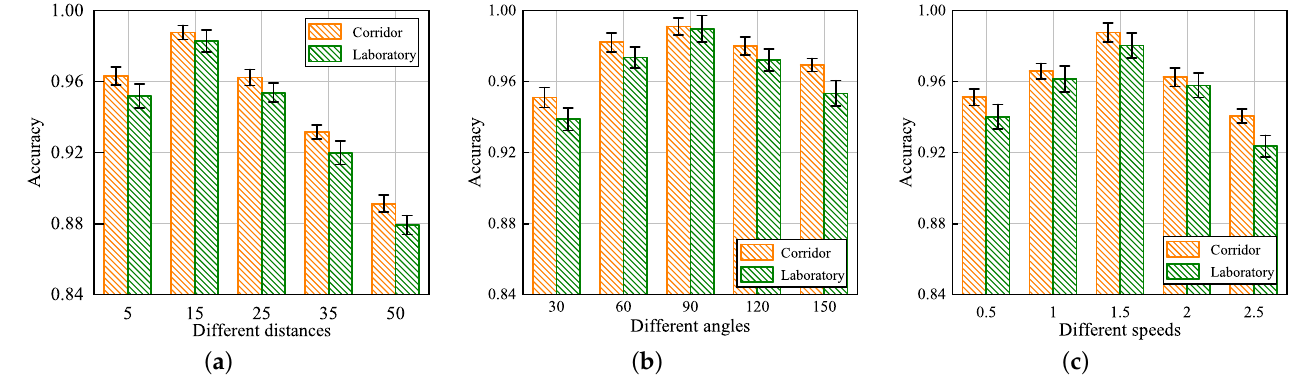
Figure 9. Impact of different distance, angles and speeds. ( a ) Impact of different distance; ( b ) impact of different angles; and ( c ) impact of different